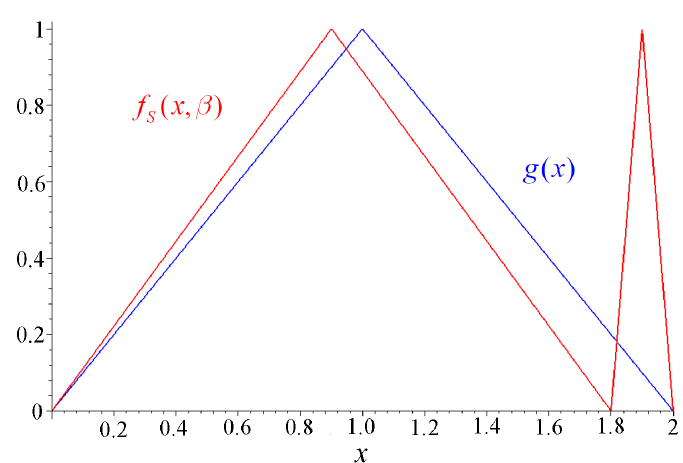
Figure 7: Plots of the densities f S ( x , β ) for β = 0.1 and g ( x ) in Example 2.